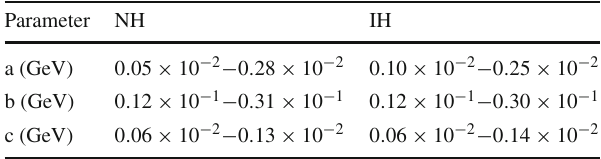
Table2 Diracmassesofthemodelandtheirrespectiveparameterspace satisfying the relic abundance of the DM candidate ξ for ω 12 = 10 − 1 + 10 − 1 i